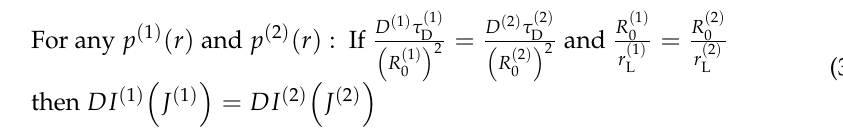
Figure 7. The results for X 0 and M (solid circles in panels ( a ) and ( b ) obtained for the range of R 0 = 9–15Å, r L = 1.5–5Å with b = 2 R 0 , and R 0 / r L > 3) were fitted to second-degree polynomial functions (solid lines in panels ( a ) and ( b ) given in Table 2).